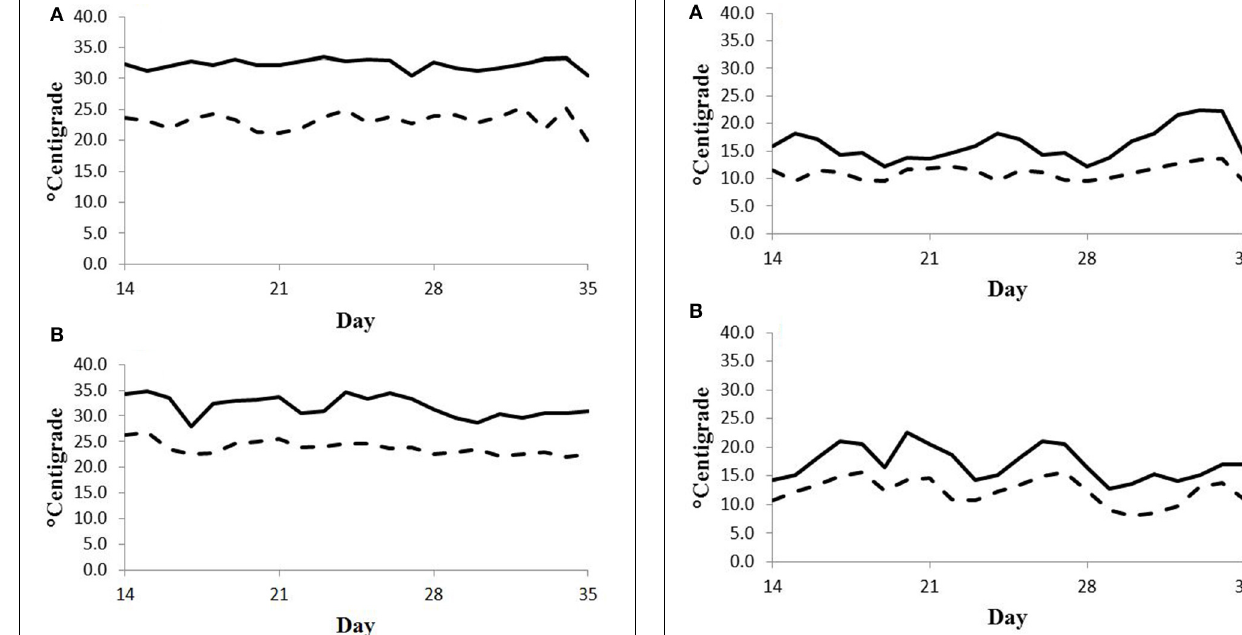
FIGURE 2 | Daily minimum (dashed line) and maximum (solid line) temperature ( ◦ C) during days 14 to 35 of period 1 (A) and period 2 (B) in Experiment 1. Day 21 was the first day of seed feeding in each period.